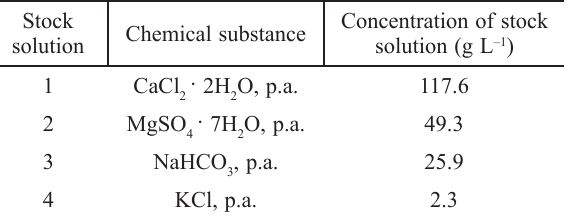
Table 1 – Stock solutions for reconstituted water